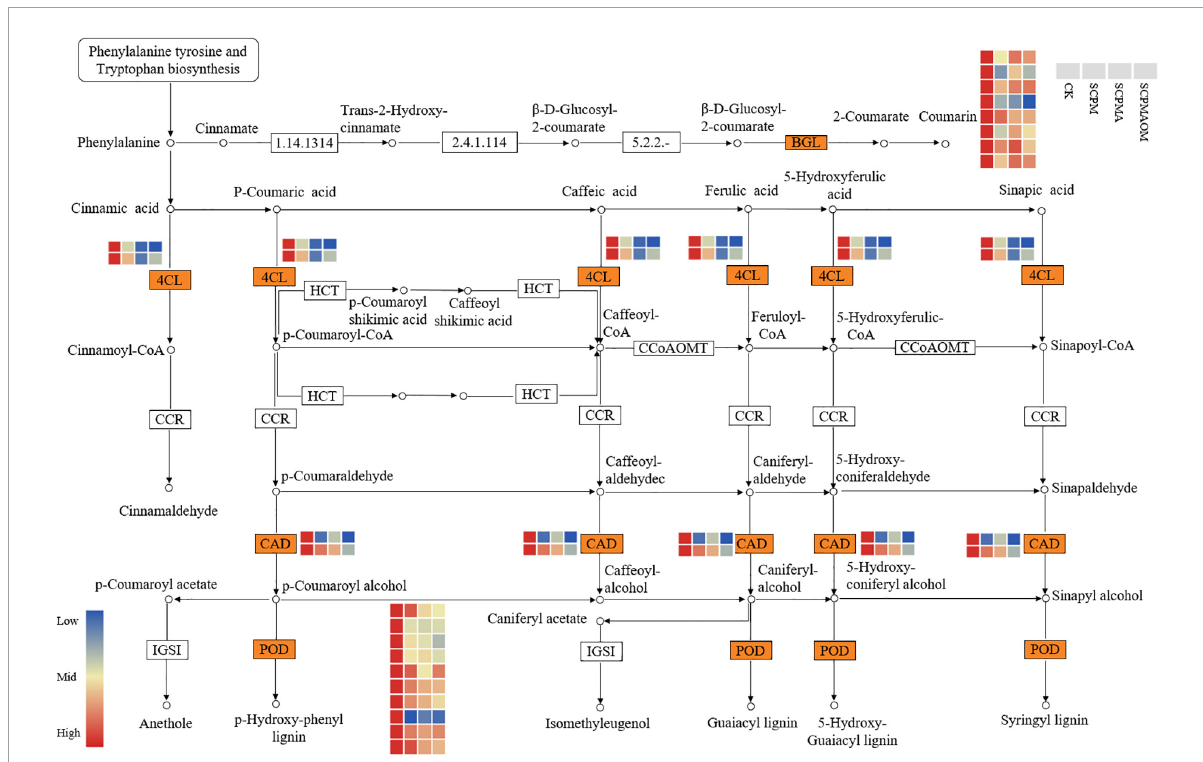
FIGURE6 Heat map of DEGs related to phenylpropanoid biosynthesis. Red color denoted genes with high expression level, while blue color denoted genes with low expression level. The relative expression levels of DEGs were calculated using the log2